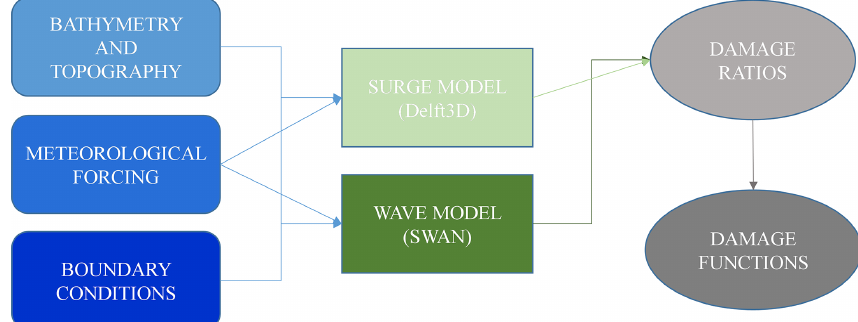
Figure 2. Flow chart of the framework used in development of damage